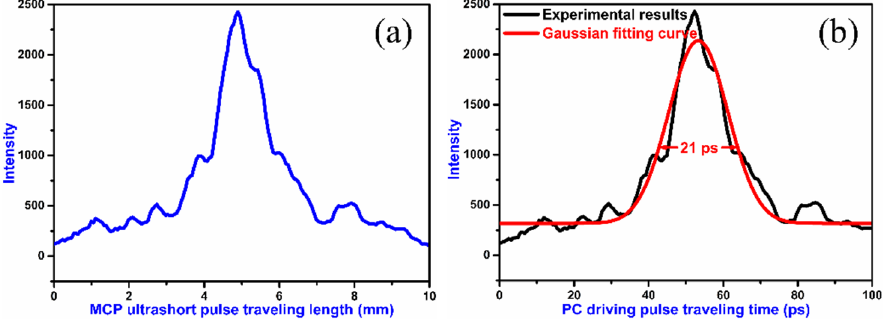
Figure 6. ( a ) The intensity versus spatial distribution along the MCP, with signals from the image in Figure 5b. ( b ) The intensity versus time distribution along the PC.